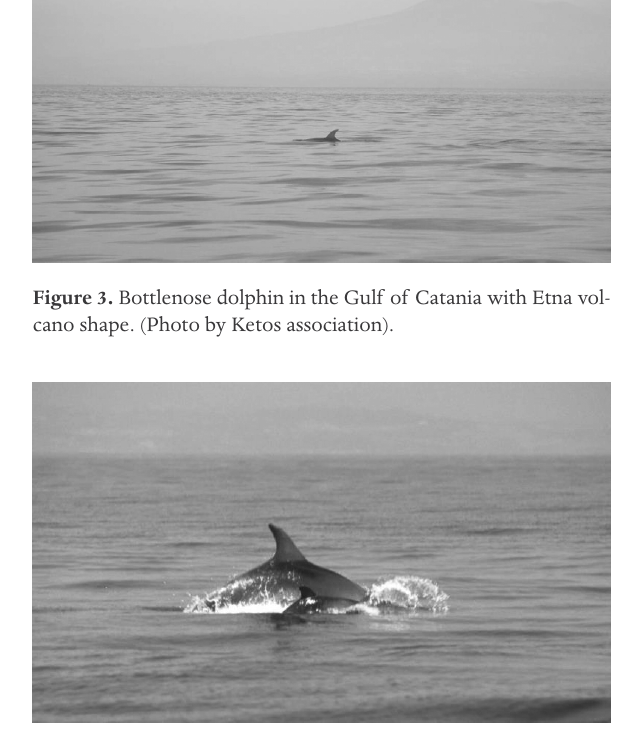
Figure 4. Bottlenose dolphin mother and cub in Ionian sea during summer. (Photo by Ketos